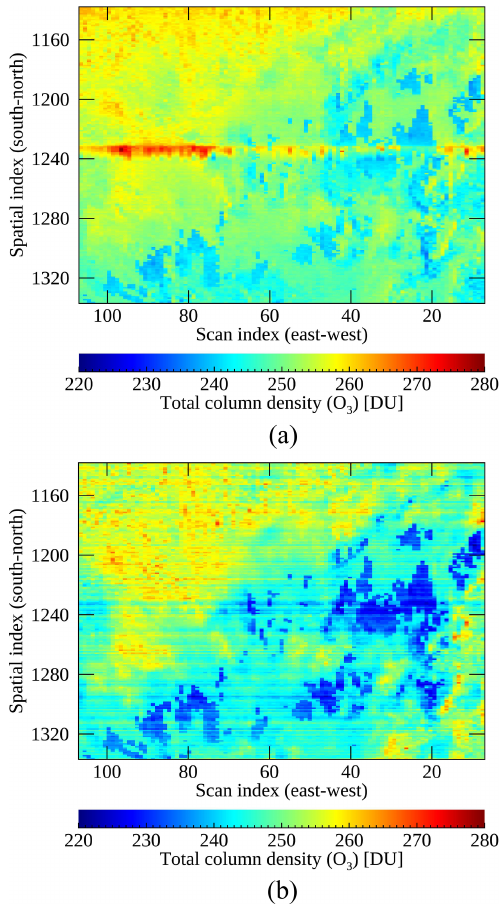
Figure 13. Spatial distribution of total ozone column density re- trieved with (a) GEMS and (b) ML radiances presented in Fig. 9. The GEMS spectra were measured on 10 March 2021